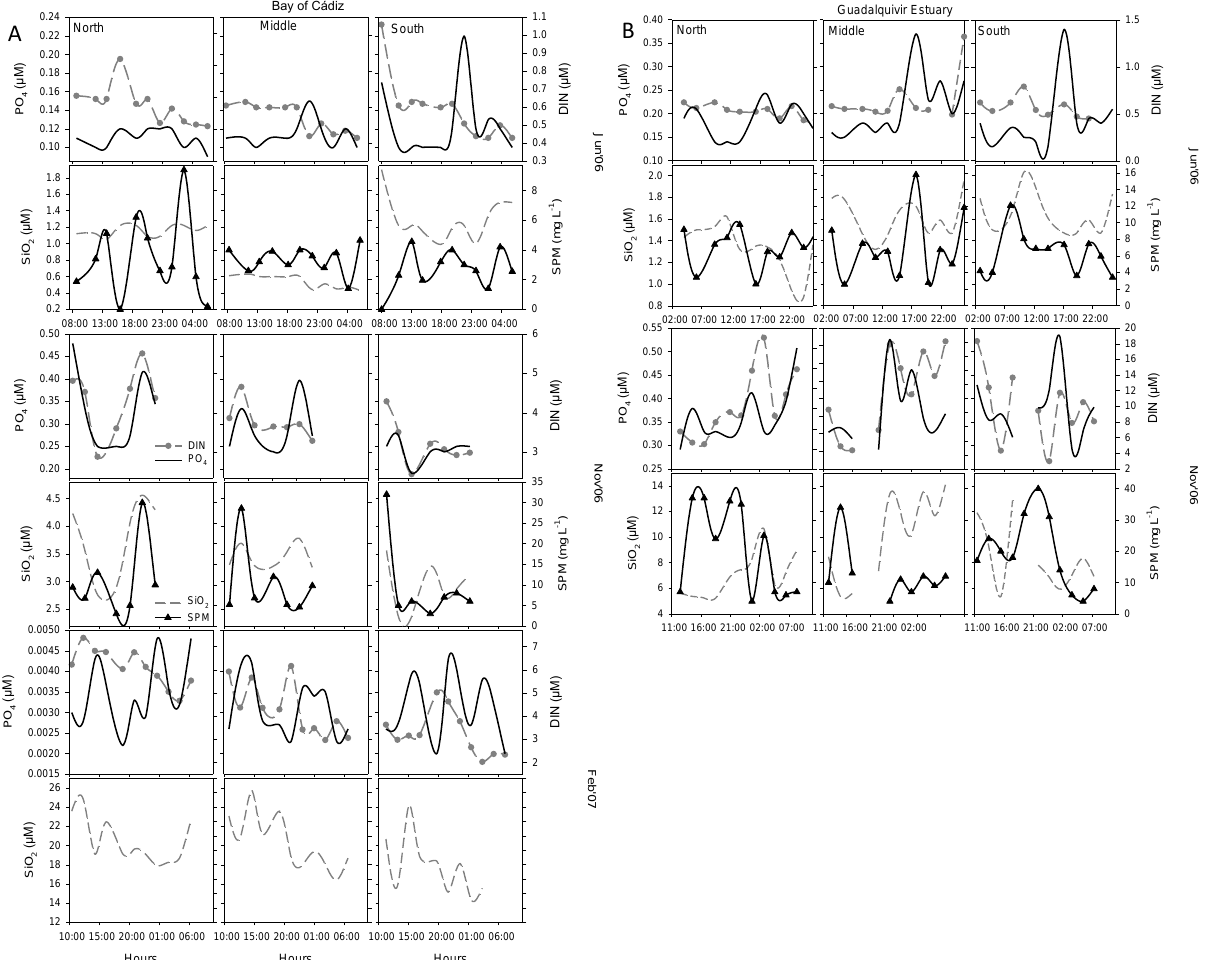
Fig. 5. Daily variations in surface seawater phosphate (PO 4 ) (black solid line), dissolved inorganic nitrogen (DIN) (grey dashed line with circle), silicate (SiO 2 ) (grey dashed line) and suspended particulate matter (black solid line with triangles) from the transect off the Bay of C´adiz (A) and Guadalquivir estuary (B) at the three different stations (Fig. 1).